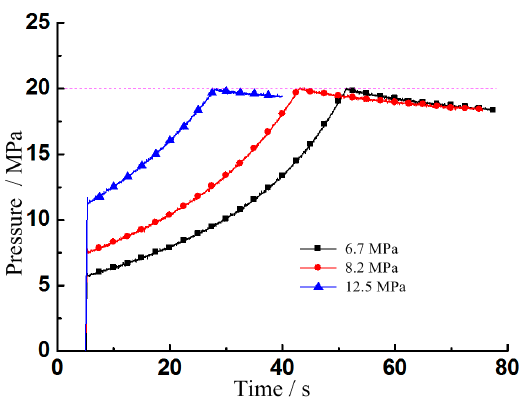
Figure 11. HA pressure with different pre-charge pressures during the energy regeneration process.